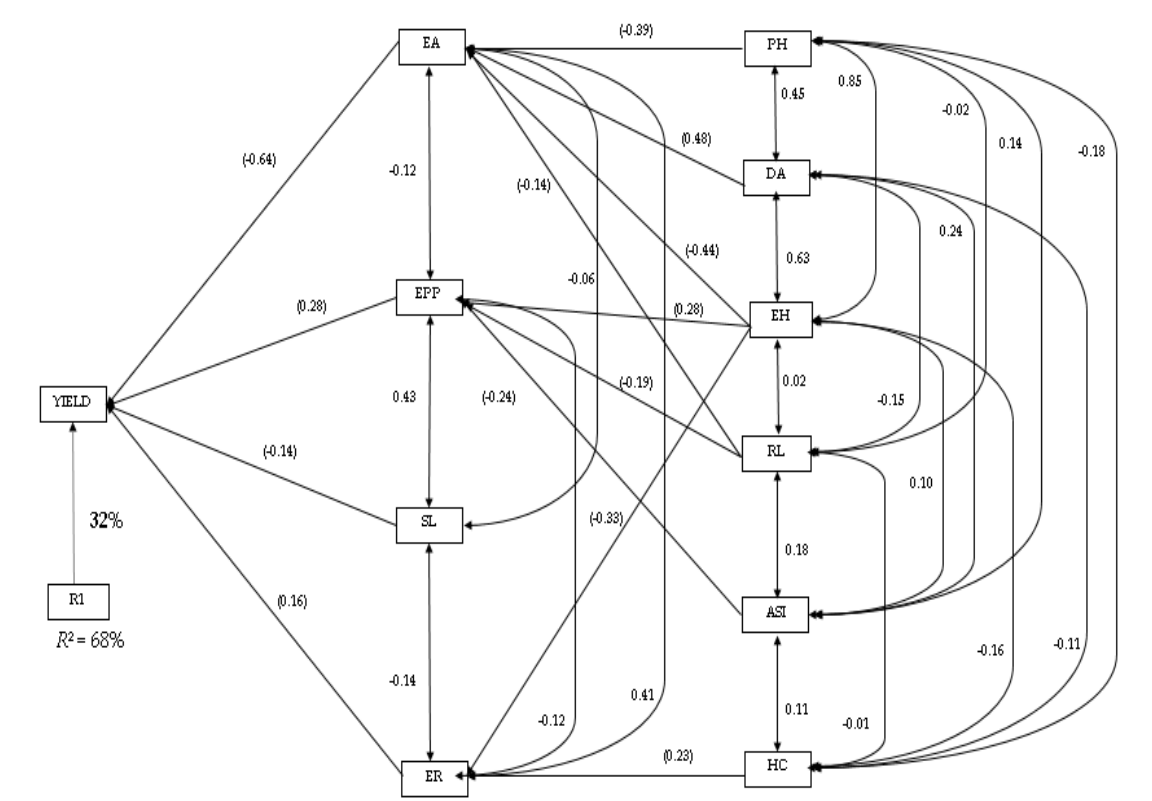
Figure 4. Path analysis showing the relationship of grain yield and agronomic traits of maize hybrids: yield, grain yield; ER, ear rot; EPP, ear per plant, EA, ear aspect, HC, husk cover, ASI, anthesis- silking interval; EH, ear height; PH, plant height; DA, days-to-anthesis; RL, root lodging; SL, stalk lodging. Values in parentheses are correlation coefficients, and other values are direct path coefficients. R1 represents the residual effects.